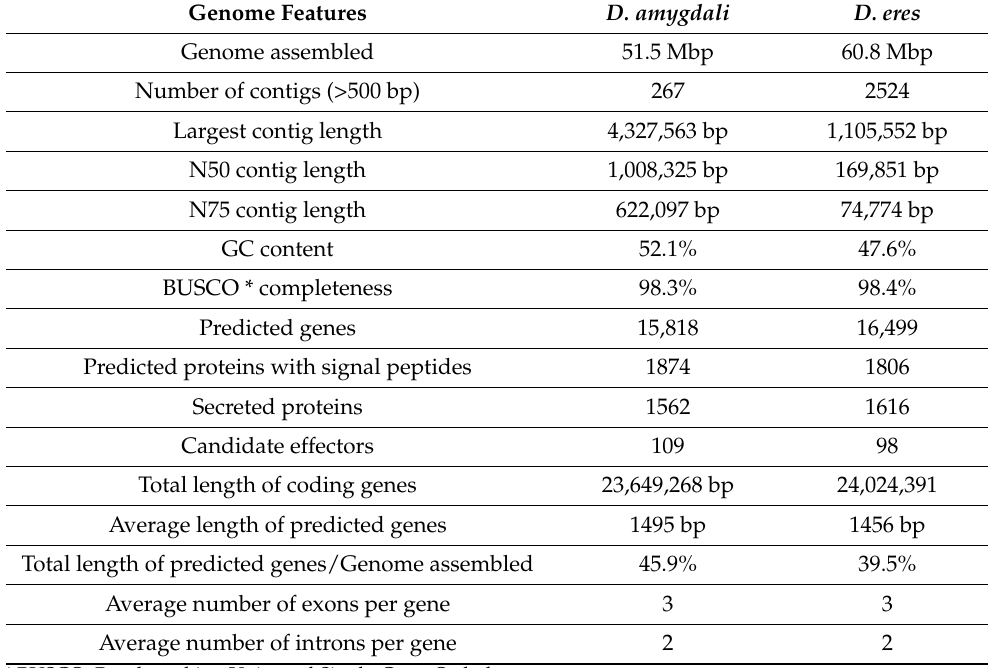
Table 1. Genome assembly overview and gene statistics for Diaporthe amygdali CAA958 and Diaporthe eres CBS